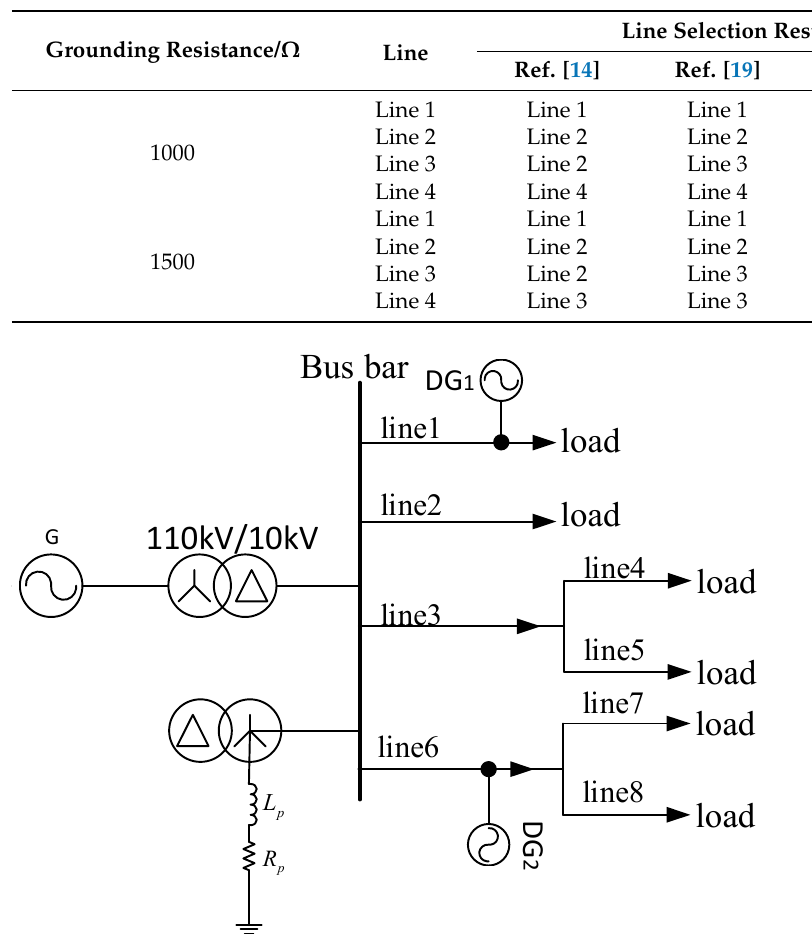
Table 6. Comparison of the experimental results of high-resistance grounding.